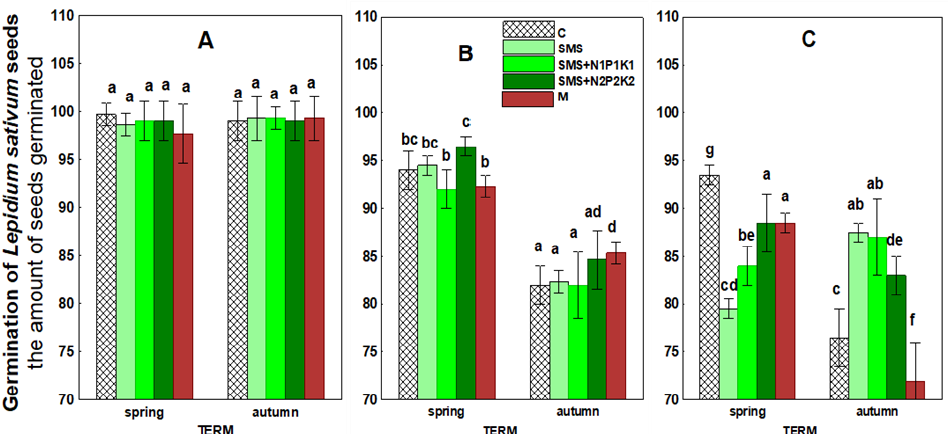
Figure 8. Lepidium sativum seed germination in the control soil and soil under different treatment strategies. ( A ) — 1st year; ( B ) — 2nd year; ( C ) — 3rd year. C — control soil; SMS — soil + spent mush- room substrate; SMS + N1P1K1 — soil + spent mushroom substrate + mineral fertilization N1P1K1; SMS + N2P2K2 — soil + spent mushroom substrate + mineral fertilization N2P2K2; M — soil + ma- nure. The vertical lines indicate the standard deviation. Different letters above the columns indicate significant differences at p < 0.05, and each year was analyzed independent of each other.